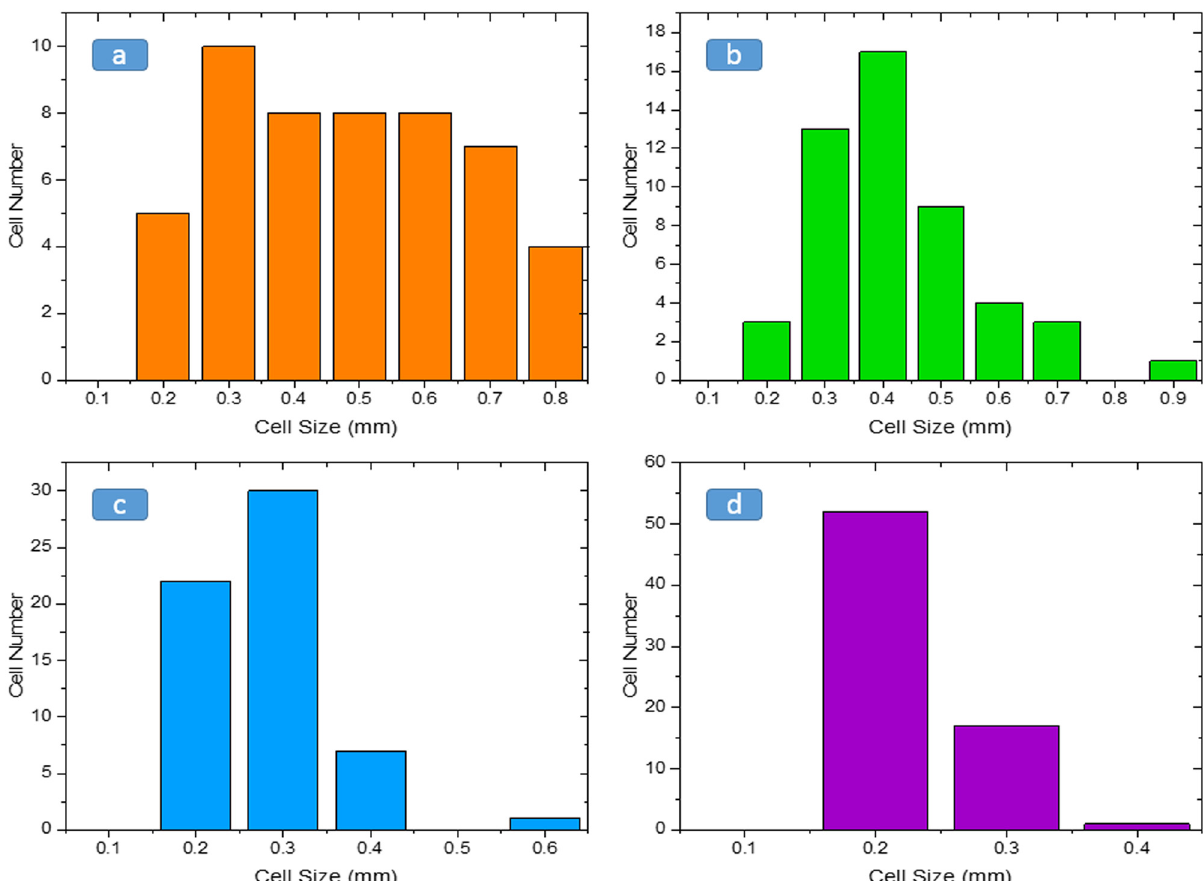
Figure 6: Distribution of cell size of foams prepared by route 1: ( a ) S10, ( b ) S20, ( c ) S30, and ( d )